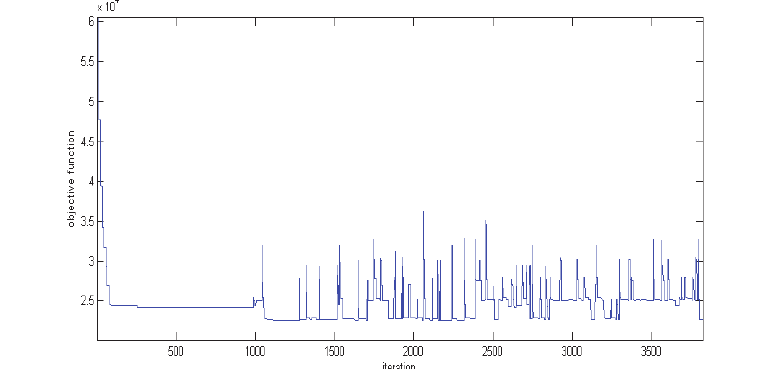
Fig. 6. Search process of the algorithm for the problem